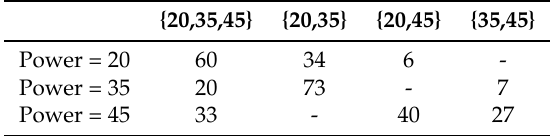
Power = 45 33 - 40 27 Note: Rows sum to 100%.